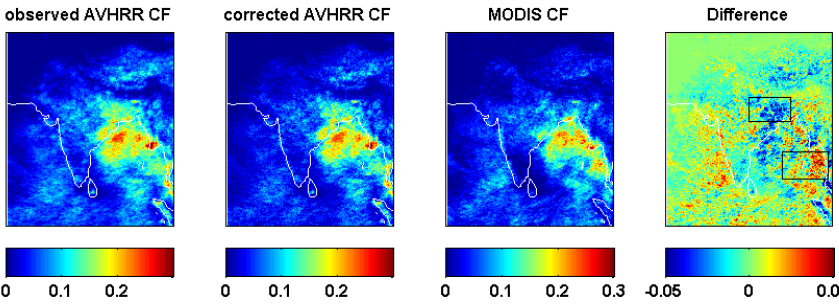
Fig. 9. Spatial distribution (from left to right panel) of uncorrected (original) AVHRR convective cloud fraction, corrected AVHRR cloud fraction after removing the drift signal, corresponding MODIS cloud fraction and the difference of uncorrected AVHRR and corrected AVHRR convective cloud fractions for the JJAS months of 2006.